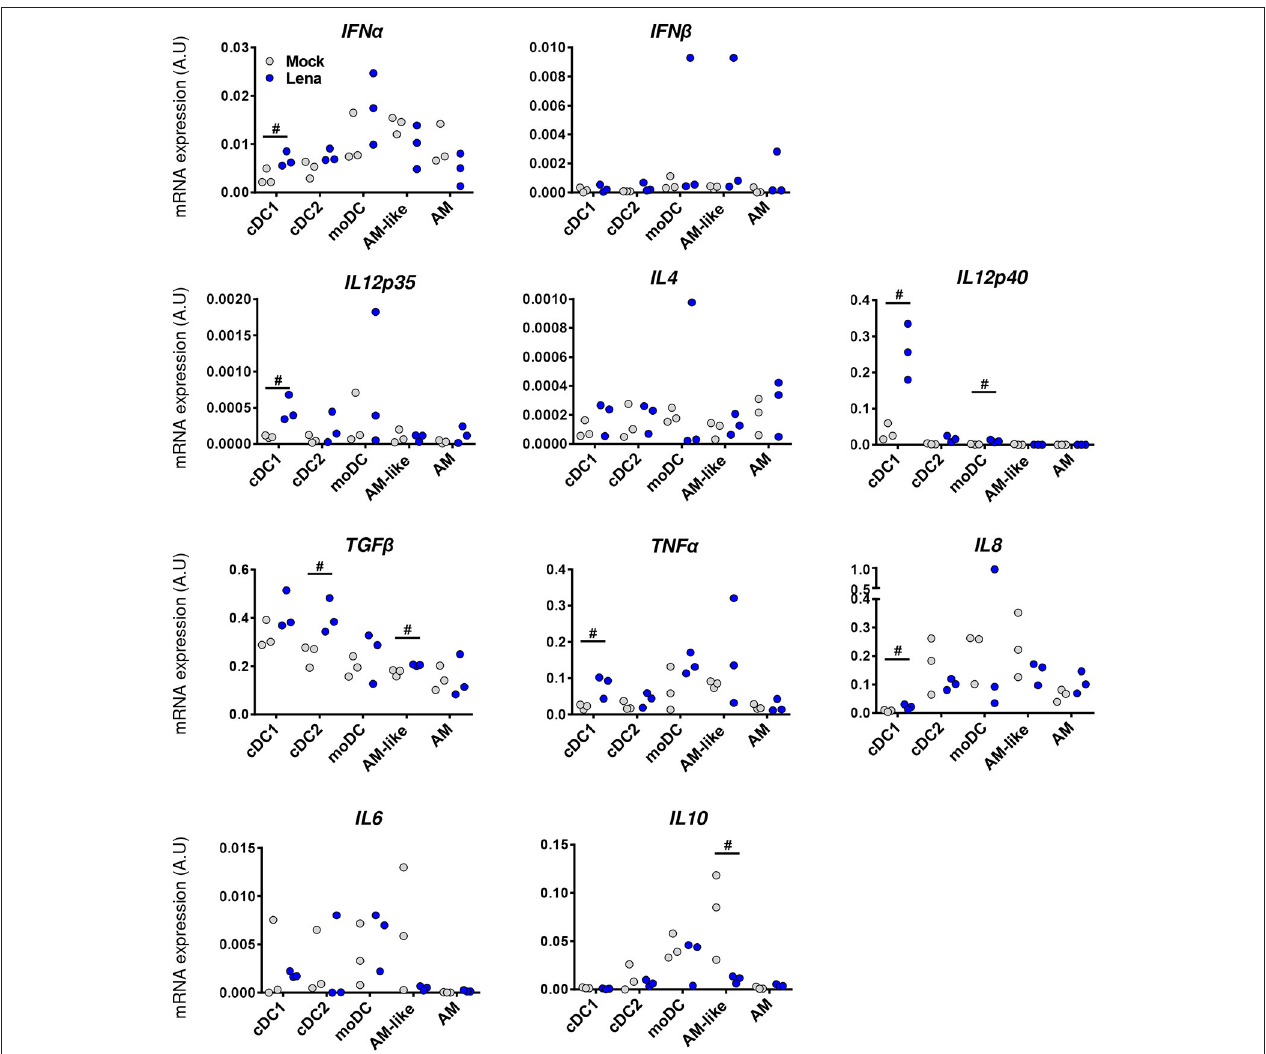
FIGURE 6 | Lena infection triggers differential cytokines responses according to DCs subpopulations. Cytokines mRNA expressions in MPC from mock (Gray Dots) or in vivo infected (Blue Dots) PAR and BAL were studied by RT-qPCR after cell-sorting. Data were normalized to the reference gene RPS24 expression. Data are representative of 3 independent experiments. Ranking tests were performed. Symbol “#” highlights when the infected animals were all upper or lower than the controls.